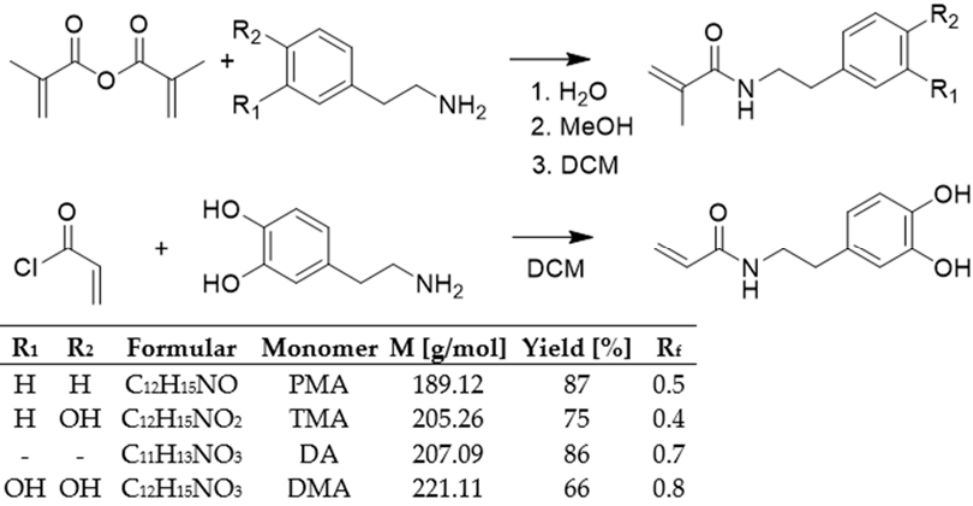
Figure 1. Synthesis of the monomers DMA (1), TMA (2) PMA (3) and DA. Molecular formula, molar masses, and